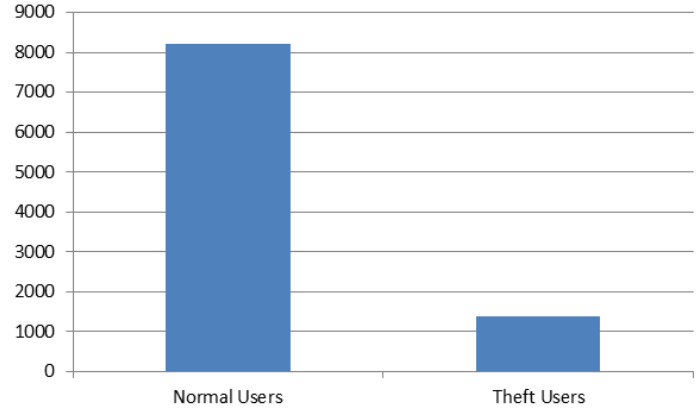
Figure 3. Distribution pattern of Normal and Fraudulent